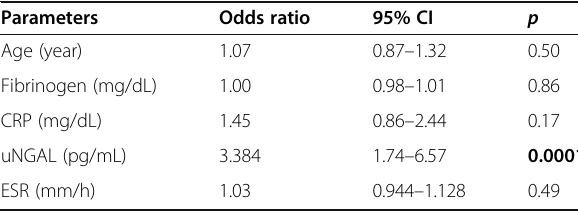
Table 3 Logistic regression analysis results in patients